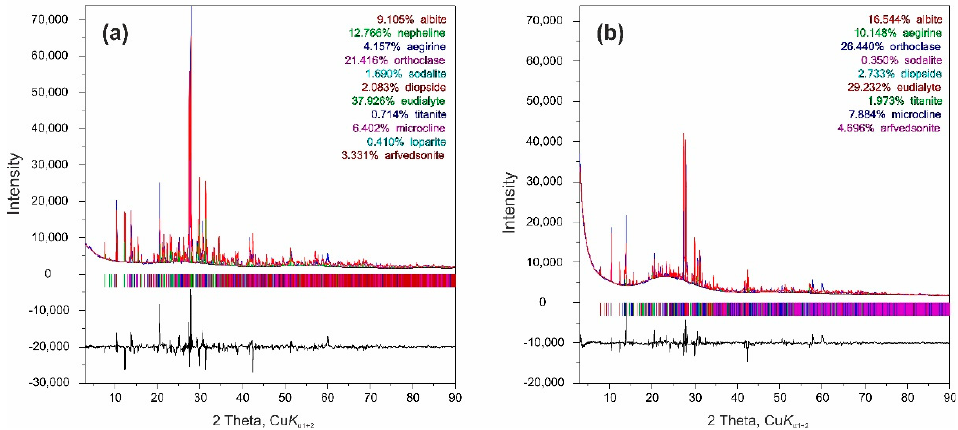
Figure 6. Rietveld refinement plot for eudialyte ore concentrate before ( a ) and after ( b ) break-